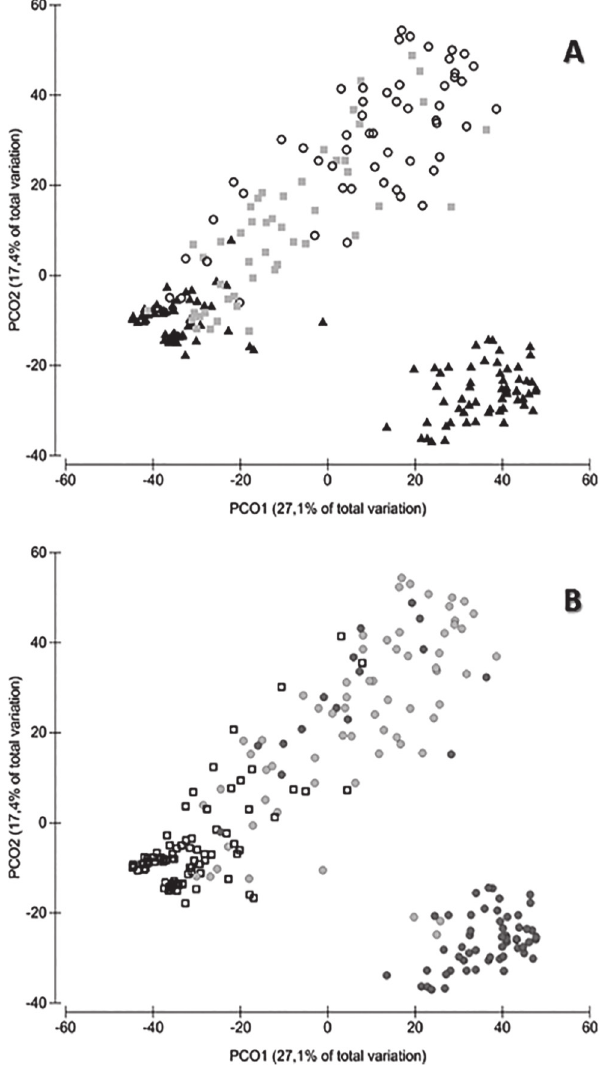
Fig. 5. Principal coordinate analysis ordination (PCO) coded by habitat (a) and size classes (b) for Atherinella brasiliensis in the Mamanguape River estuary, Brazil. Symbols Habitat: Mud flat (Full Black Triangle); Tidal Creek 1 (Gray Square); Tidal Creek 2 (Black Circle); Symbols size classes: Small juveniles (Open Black Square); Juveniles (Light Gray Circle) and Adults (Dark Gray Circle).